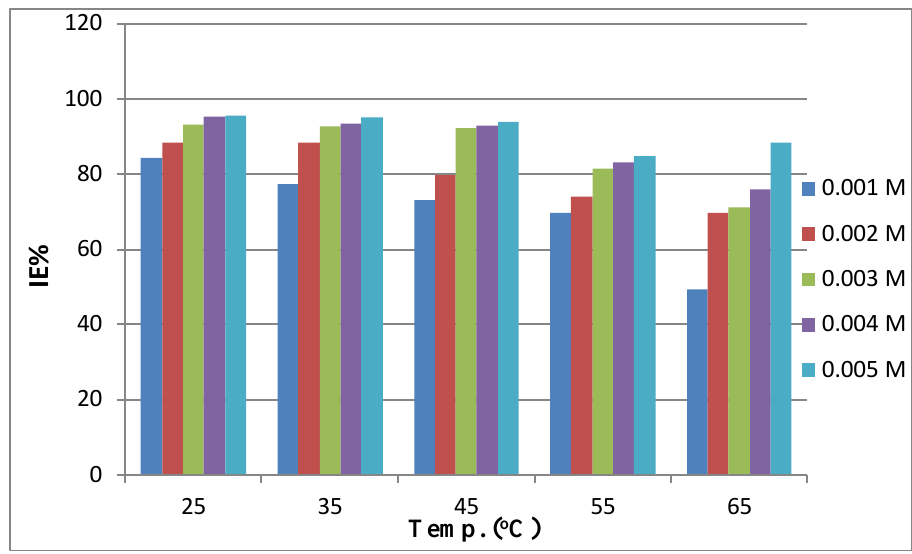
Figure 6: Inhibition Efficiency for different temperatures at varied ABCP concentrations.